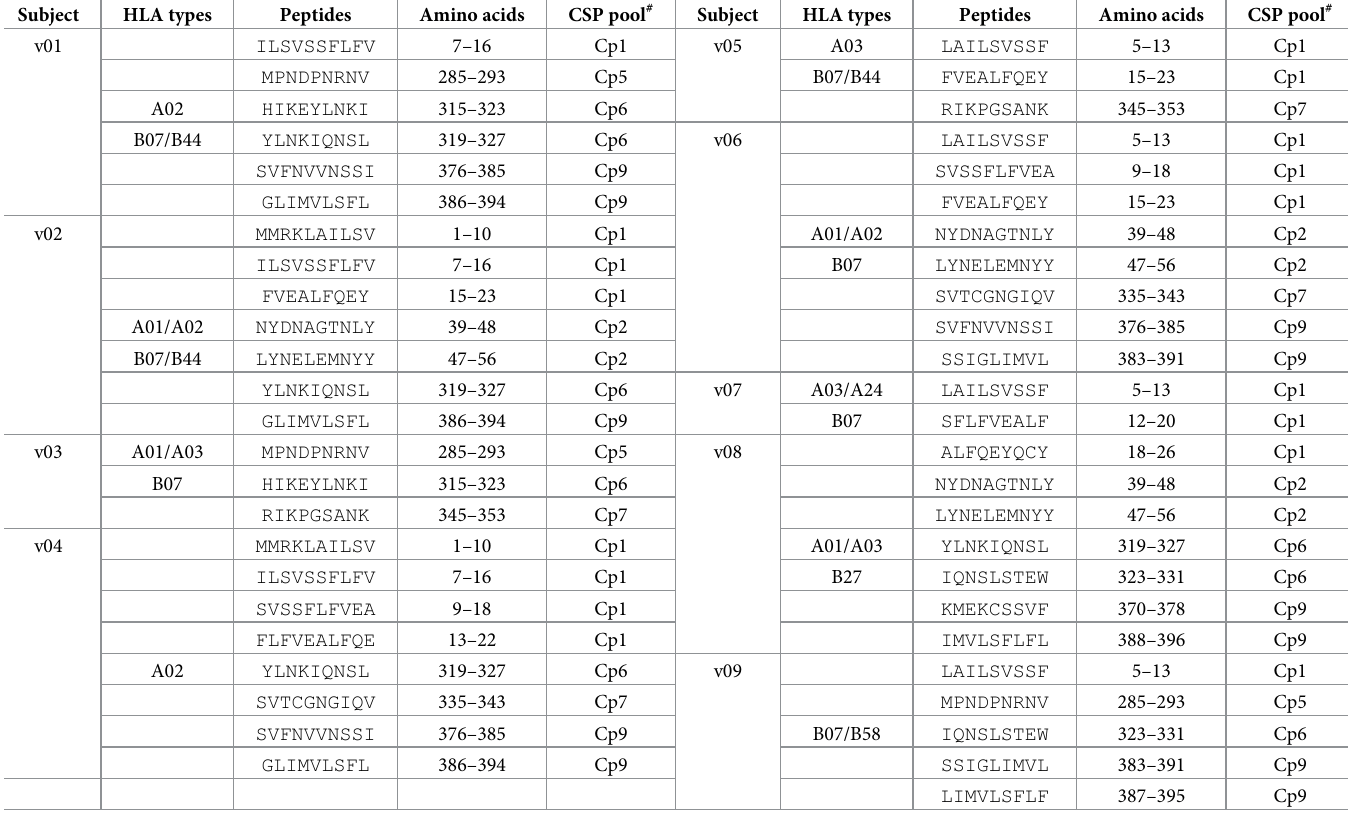
Table 1. Peptides used to stimulate study subject